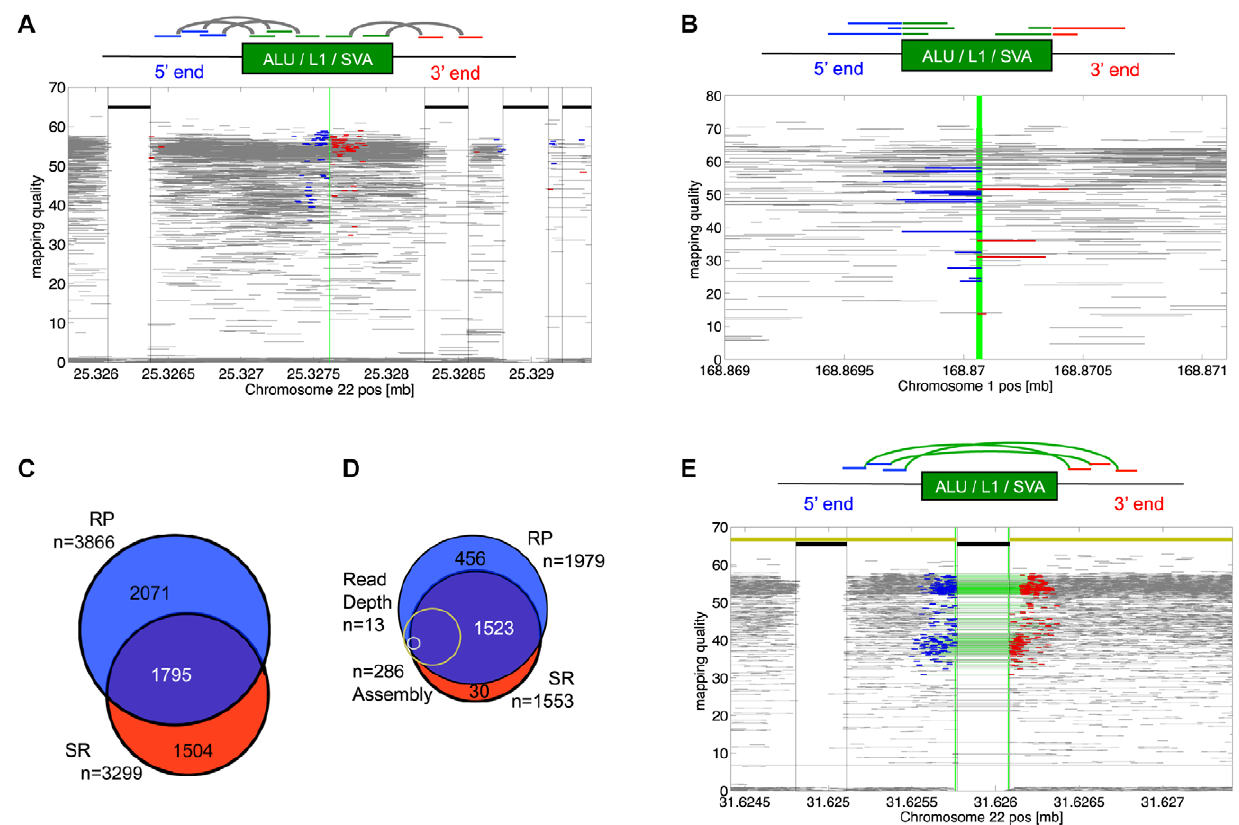
Figure 1. MEI detection modes. a) RP signature for of non-reference MEI detection. The RP signature consists of Illumina read pairs spanning into the element from each side of the insertion. The RP event display shows a heterozygous Alu insertion allele on chromosome 22 from the trio pilot dataset. Fragment mapping quality is shown on the vertical scale. Horizontal grey lines show read pairs uniquely mapped at both ends with a mapped fragment length consistent with the sequence library; the blue and red lines are read pairs spanning into an Alu sequence from the 5 9 and 3 9 ends. The green vertical line is the position of the insertion. Thick black lines near the top show annotated Alu positions. Red and blue reads bracketing annotated elements are characteristic of mapping artifacts that we removed from insertion detection by masking out regions within a fragment length of an annotated element of the same family as the insertion. b) Signature for SR-based insertion detection. Split-mapped 454 reads span into the element sequence. The SR event display shows split reads spanning into an Alu insertion from the 5 9 (blue) or the 3 9 (red) sides. The vertical green line marks the insertion site. Fully mapped 454 reads are shown in gray. Gray reads that span the breakpoint correspond to the reference allele. Note that the mapping quality increases with the length of the split-mapped segment. The red and blue segments overlap by roughly 15 bp in the target site duplication region that brackets the MEI insertion. c) Overlap between non-reference MEI detected by RP and by SR. d) Overlap between detection methods for reference MEI. Of the 23 1000GP deletion call sets, 11 were RP and 4 were SR. Also shown are the relative proportions of events detected by assembly (yellow) and by read depth (gray) both of which had nearly 100% overlap with RP and SR calls. e) RP signature for reference MEI detection. Read pairs with abnormally long mapped fragment lengths (in green) span over an AluYb8 annotation. The event display shows RP evidence for a homozygous reference MEI in chromosome 22 from the trio dataset. The yellow line at the top marks homologous regions from the chimpanzee assembly, with a gap at the precise location of the variant